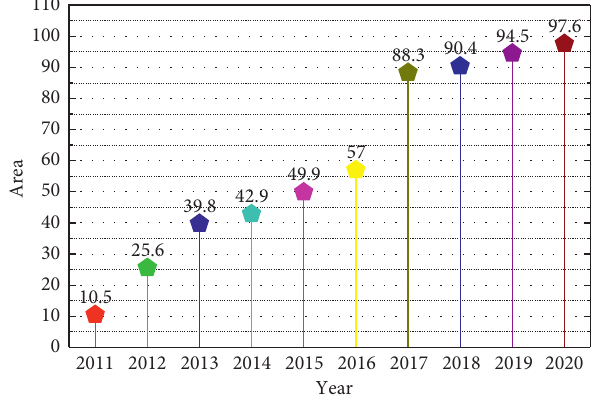
Figure 6: Change in a total area of built-up